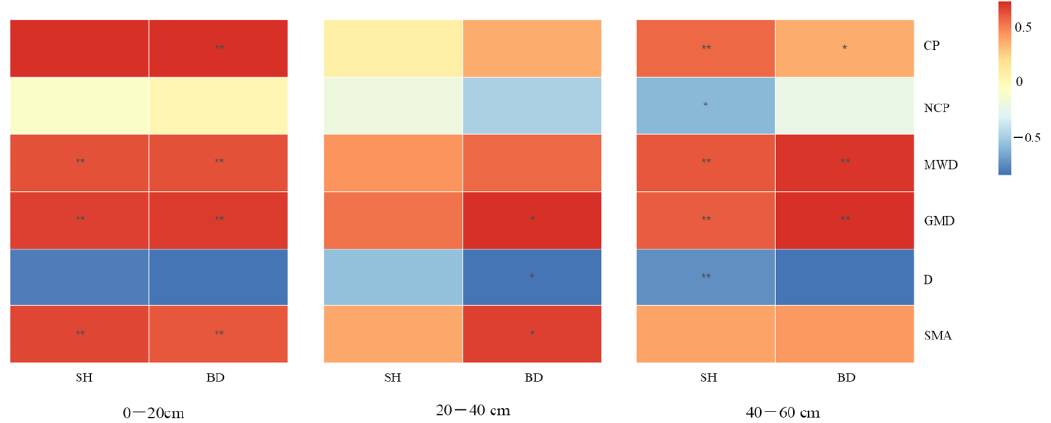
Figure 5. Abbreviations: SH—seedling height growth rate; BD—basal diameter growth rate; CP— capillary porosity; NCP—non-capillary porosity; MWD—mean weight diameter; GMD—geometric mean diameter; D—fractal dimension; SMA—soil microbial activity. * indicates significant correlation at 0.05 level; ** indicates significant correlation at 0.01 level.